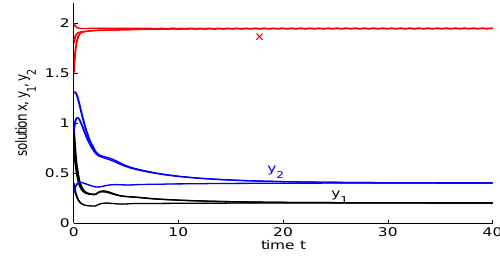
Figure 9: µ = 2 , τ = 2 , E * = (1.9487, 0.1998, 0.3996) of system (1.4) with different initial values is globally attractive.